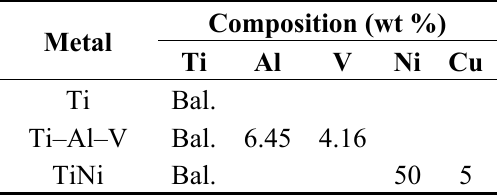
Table 1. Chemical composition of the starting materials used in the present study.